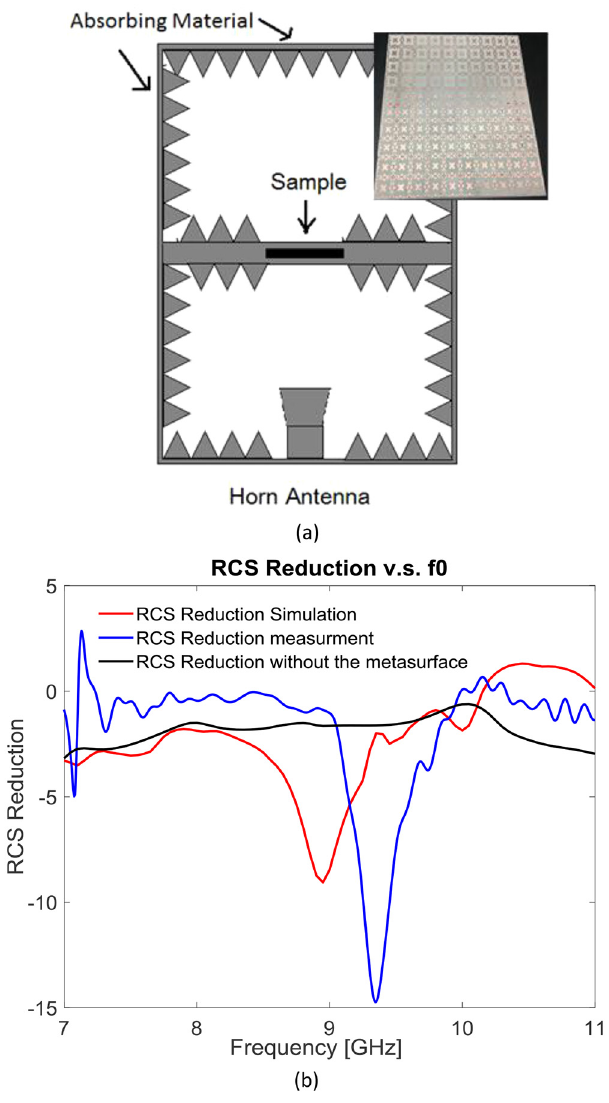
Fig. 7. (a) Diagram of the measurement setup and the fabricated metaferrite based U-slot patch antenna, (b) the Simulated and measured RCS reduction results of the metaferrite antenna and the comparison between the same patch antenna with the conventional dielectric